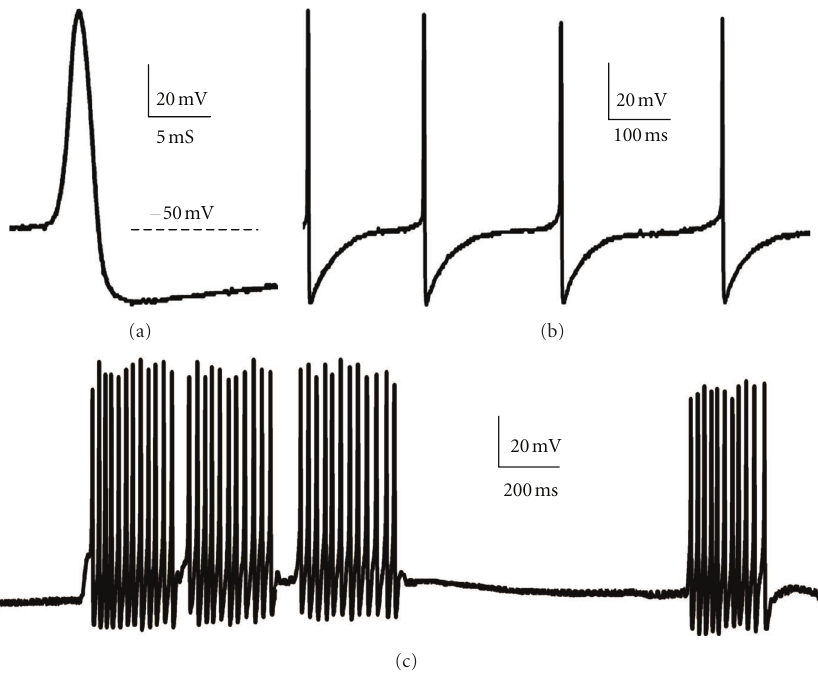
Figure 5: Activity of dorsal unpaired median (DUM) neurons from terminal abdominal ganglion, examined with the microelectrode technique. (a) Single action potential and (b) regular spontaneous activity recorded from the neuron in the ganglion—in in situ conditions, in control. (c) Radical change of neuron regular beating discharges into bursting activity in Lqh α IT (10 − 6 M)